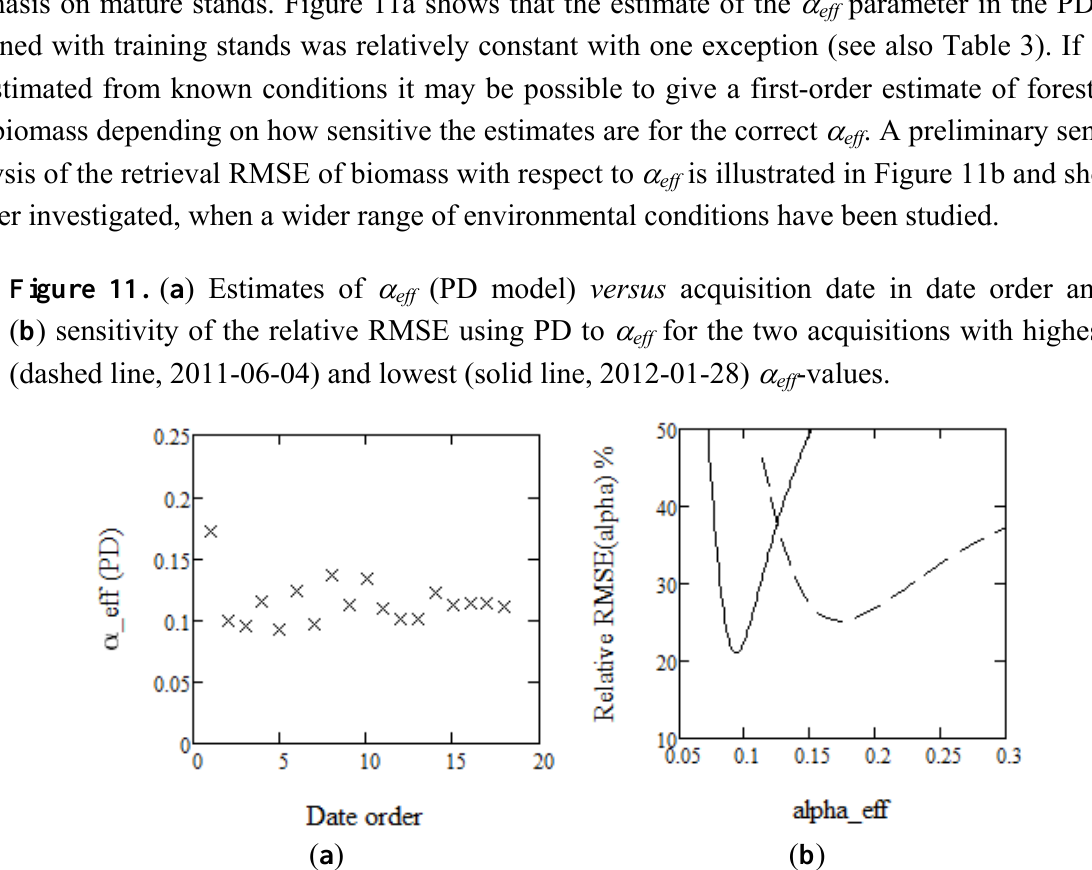
(PD model) versus acquisition date in date order and eff for the two acquisitions with highest eff eff